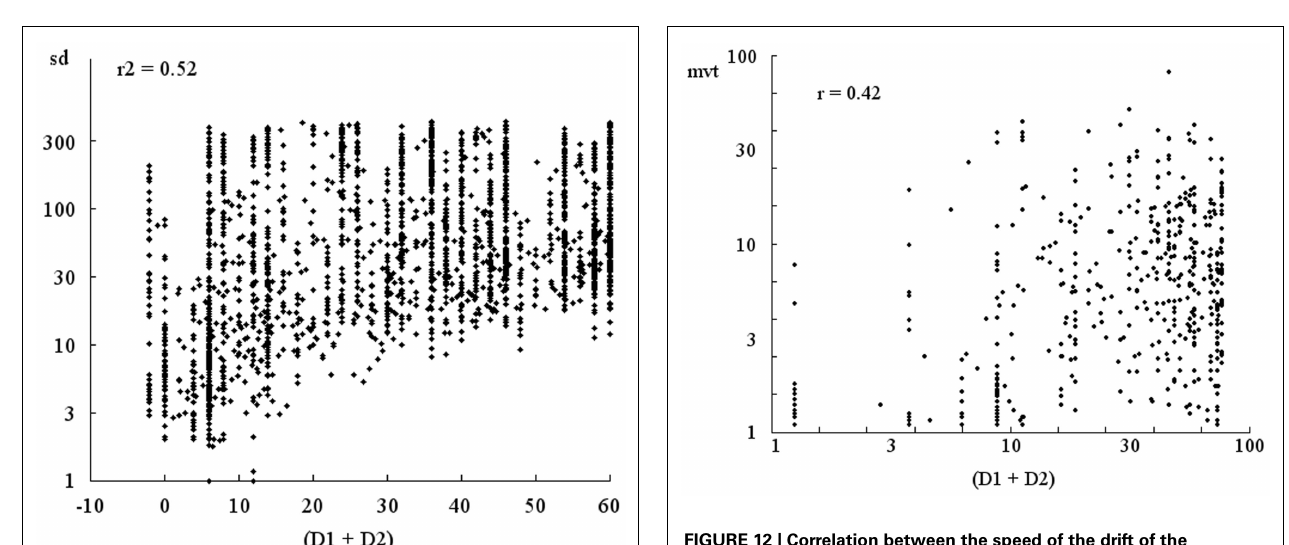
FIGURE 12 | Correlation between the speed of the drift of the perceptual crossing and ( D 1 + D 2). The rate of drift of the mean position over a 5-s interval, “mvt,” decreases as the disequilibrium ( D 1 + D 2) decreases.The correlation coefficient of 0.342 is highly